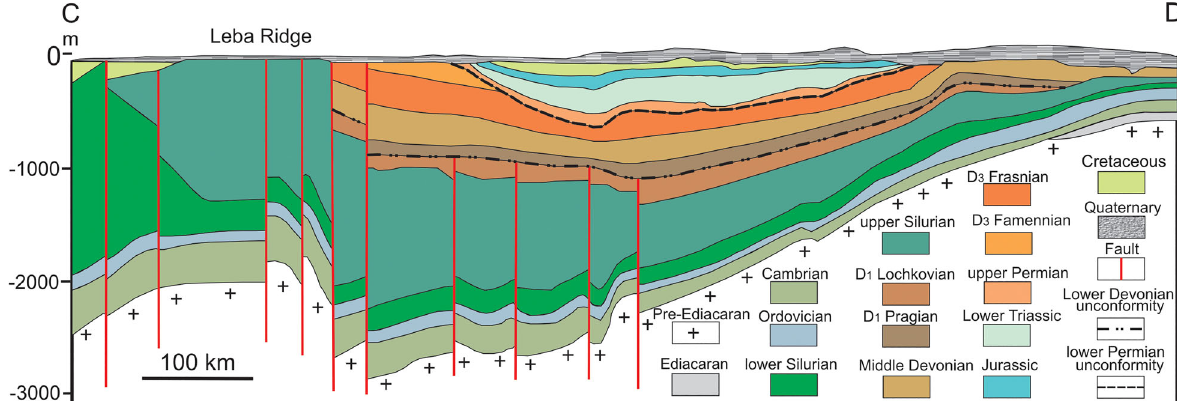
Fig. 5. Subparallel geological cross section from Lithuania across the Leba Ridge in the southern Baltic Sea (modified after Šliaupa & Hoth 2011). For location see Fig.